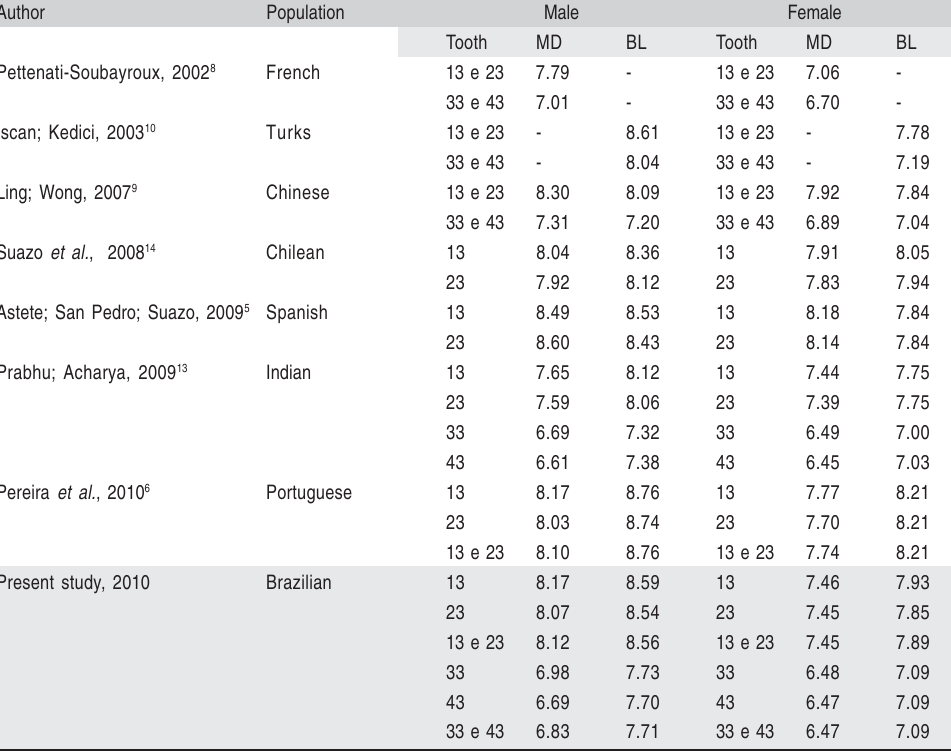
Table 2. Differences between averages of the mesiodistal (MD) and buccolingual (BL) dimensions in the sample studied and in other populations. João Pessoa, PB,